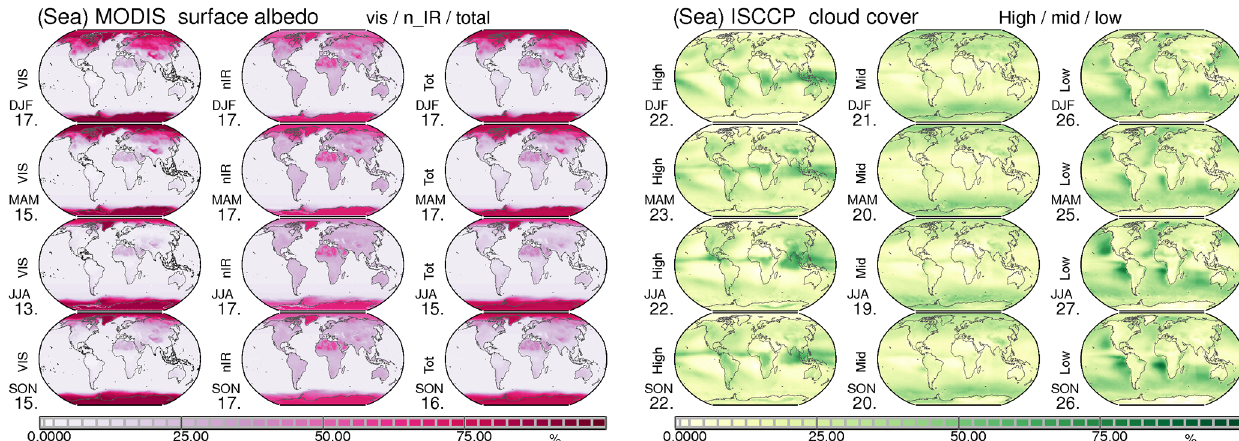
Figure 4. Seasonal averages for applied environmental properties to (1) solar surface albedo (left frame) for the UV/VIS, the near-IR and the total spectral range based on MODIS satellite sensor data and (2) ISCCP-based cloud cover (right frame) for high ( < 440hPa), middle (440–680hPa) and low ( > 680hPa)